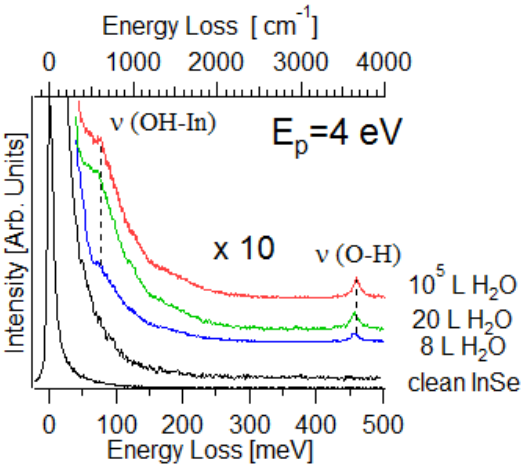
Figure 10. Vibrational spectrum of InSe exposed to water molecules at room temperature. Reproduced with permission from Ref. [20]. Copyright Royal Society of Chemistry, 2016.